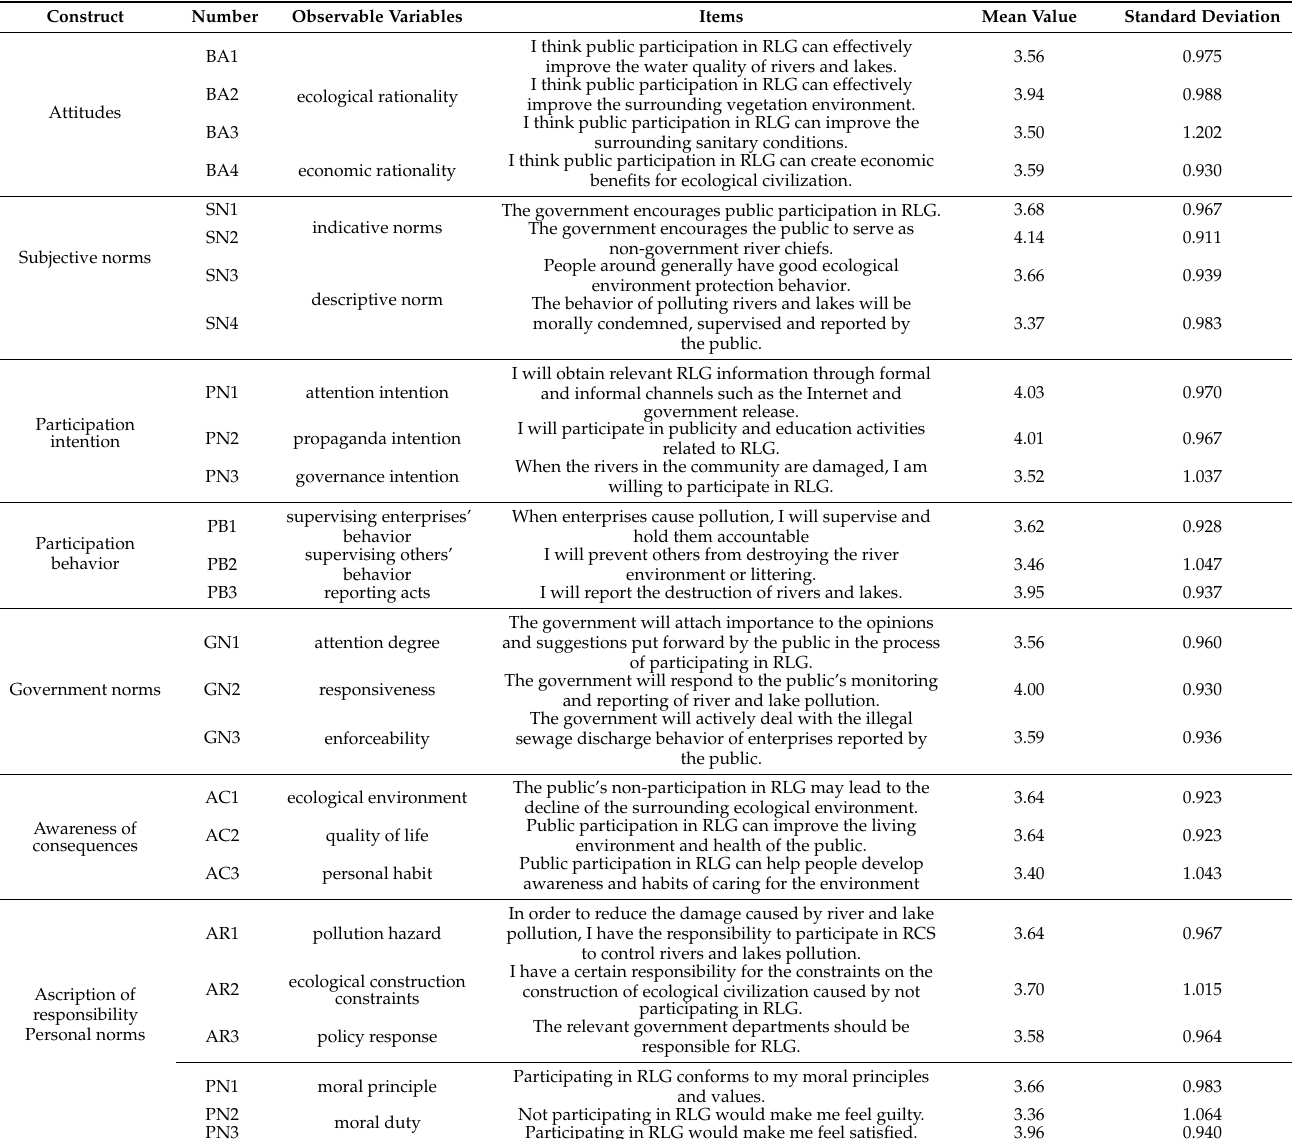
Table 1. Questionnaire on public participation in RLG ( n =